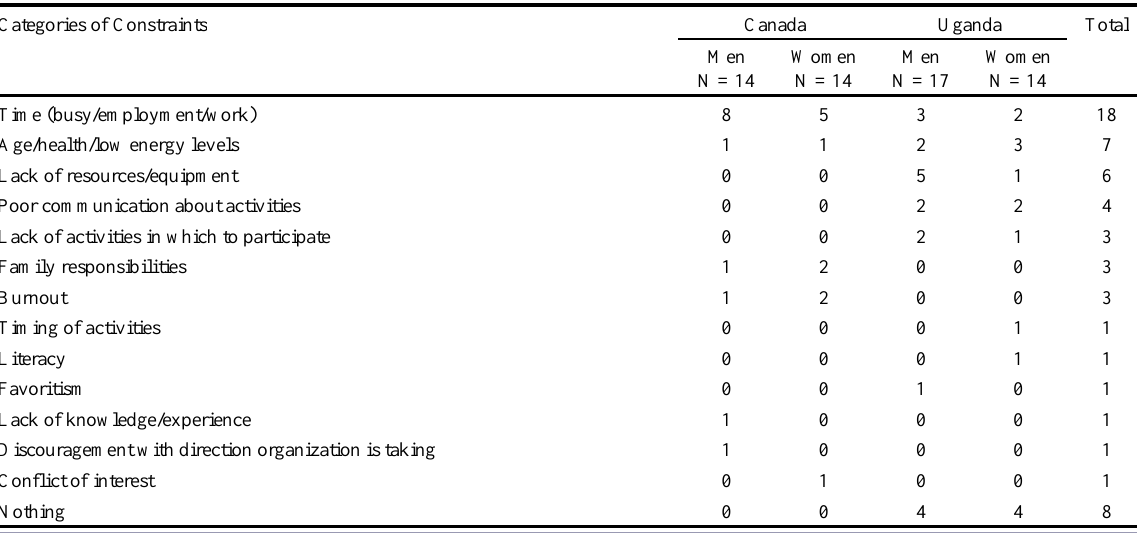
Table 5. Personal constraints to participation as identified by interviewees.